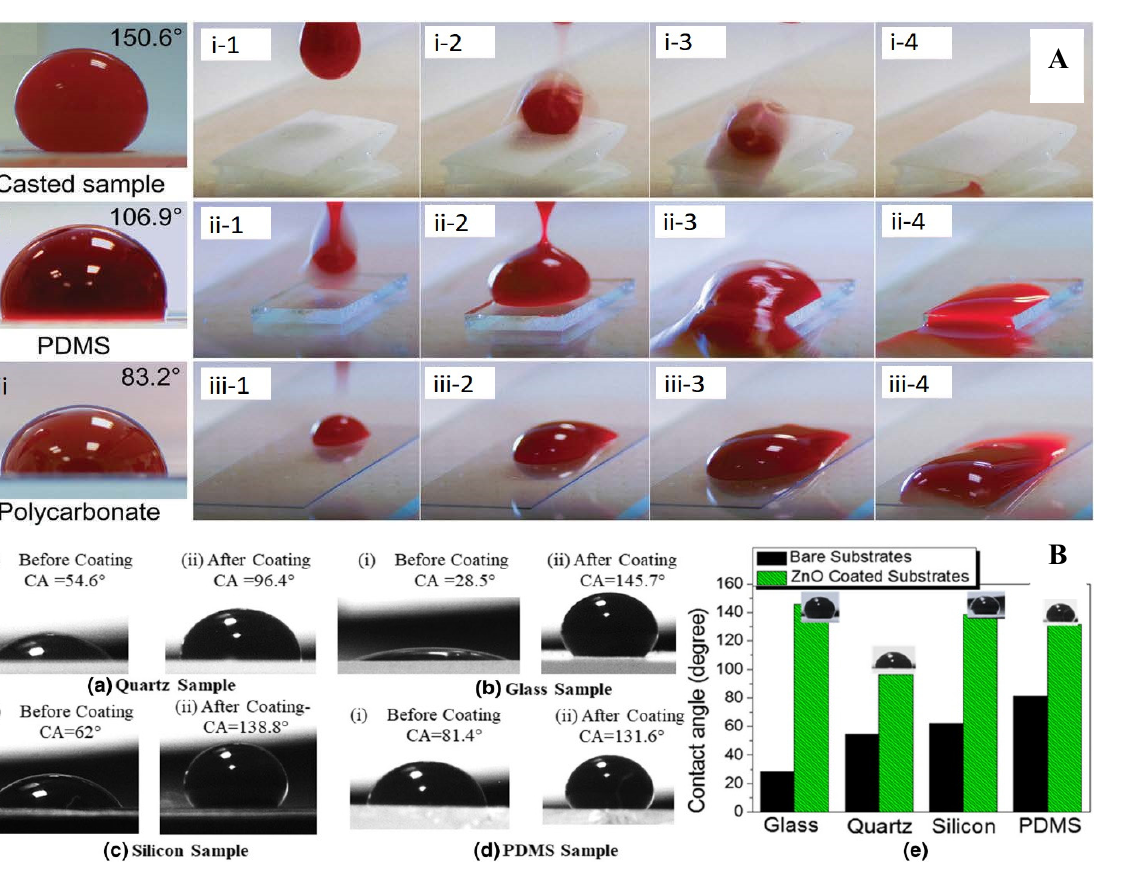
Figure 7. ( A ) Blood-repelling properties of the sand-casted superhydrophobic sample compared with common materials, and blood rolling off the samples: ( i ) superhydrophobic sample, ( ii ) PDMS, ( iii ) polycarbonate; research by Li et al. [75]; ( B ) contact angle measurements on various substrates before and after ZnO nanowire coating application; reported by Singh, A. and S. Singh [56].